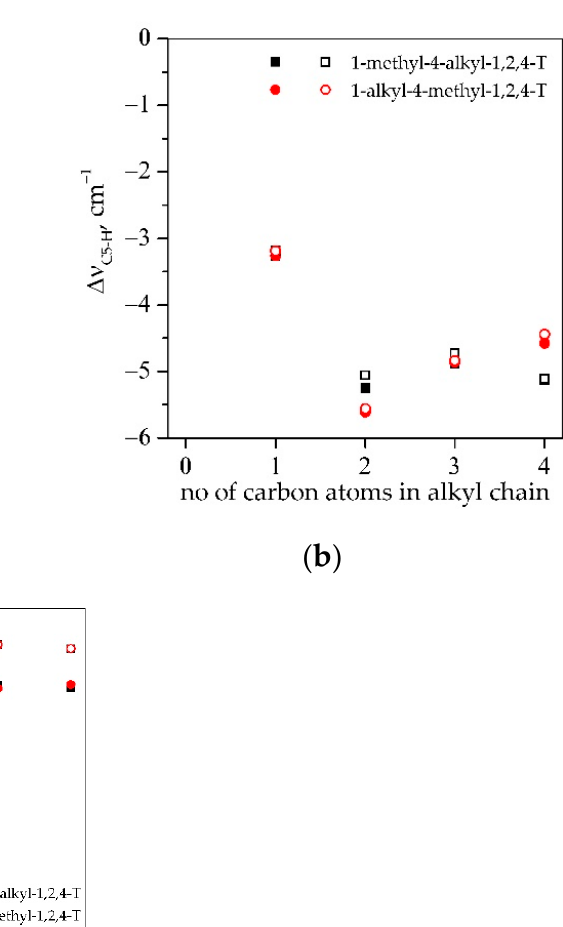
Figure 3. FTIR spectra of pristine PETMP (thiol monomer), METNTf 2 (triazolium ionic liquid), and a composition of PETMP+TATT+MET+PC. Additionally, shifts in the investigated absorption bands C3-H and C5-H of the triazole ring and SH group of thiol are shown (the absorbance has been normalized to show shifts in the studied bands).